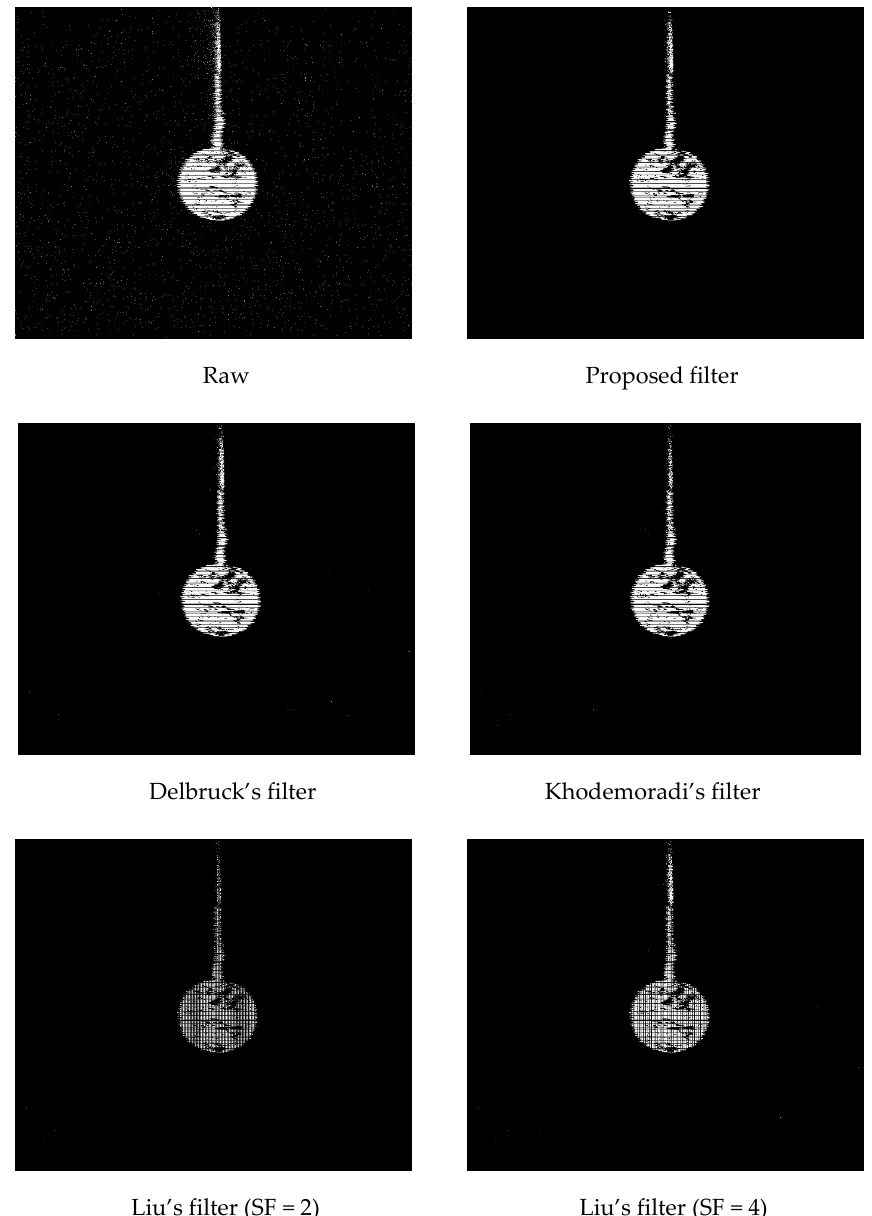
Figure 10. Binary images of the raw image and the events passed by the five filters at 3923 ms .